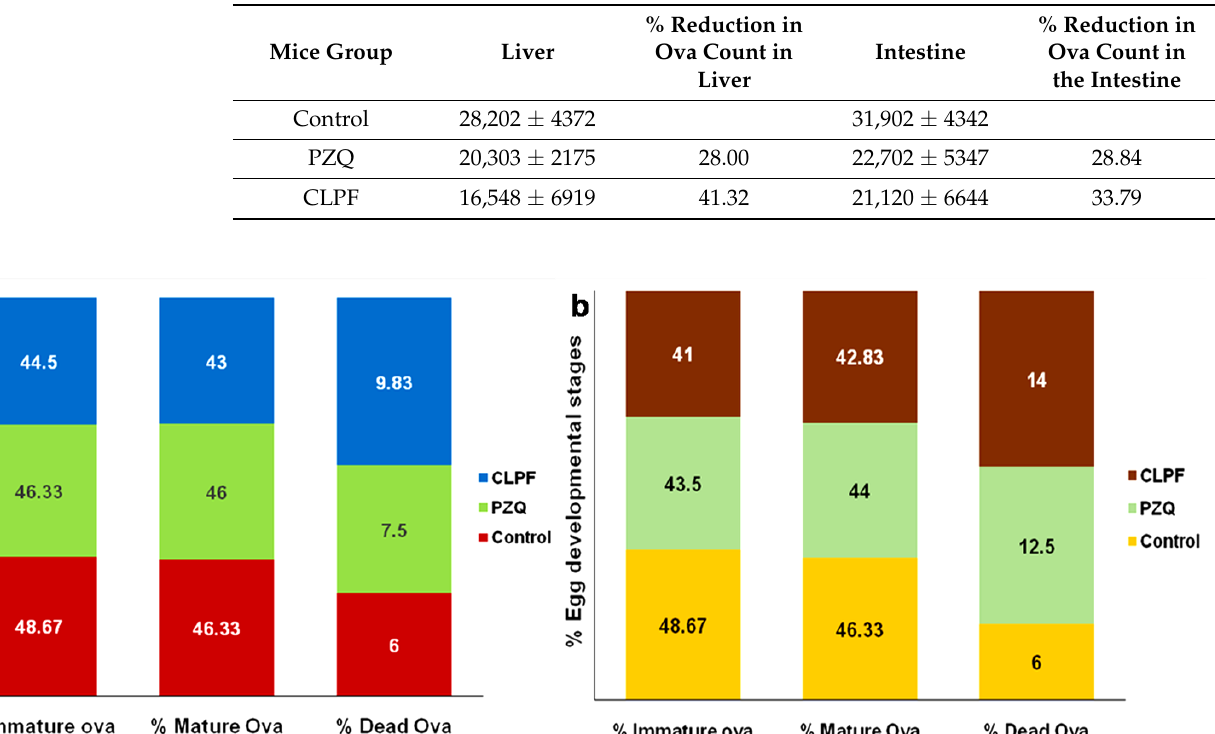
Figure 16. Effects of PZQ and CLPF:( a ) (single dose 250 mg/kg two weeks post-infection) on % egg developmental stages in S. mansoni -infected mice euthanized six weeks post-infection; ( b ) (single dose 250 mg/kg four weeks post-infection) on % egg developmental stages in S. mansoni -infected mice euthanizedsix weeks post-infection.